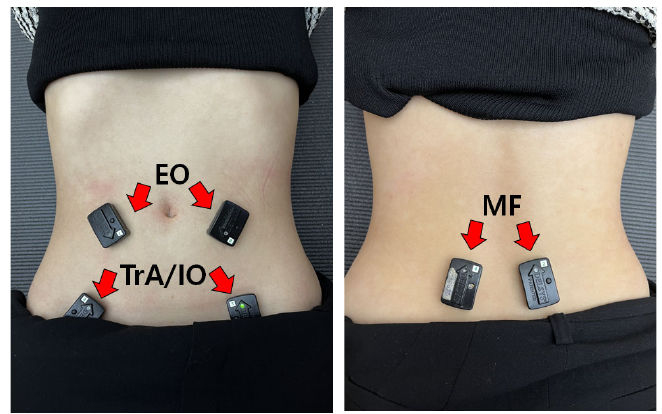
Figure 1. Surface Electromyography sensor attachment.